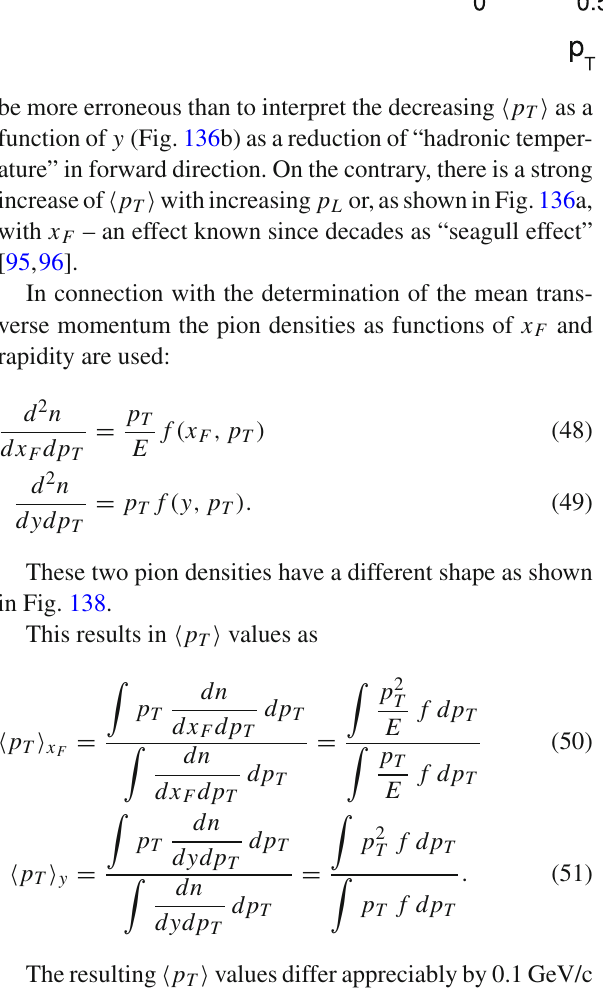
The corresponding (cid:4) p T (cid:5) x as given in Table